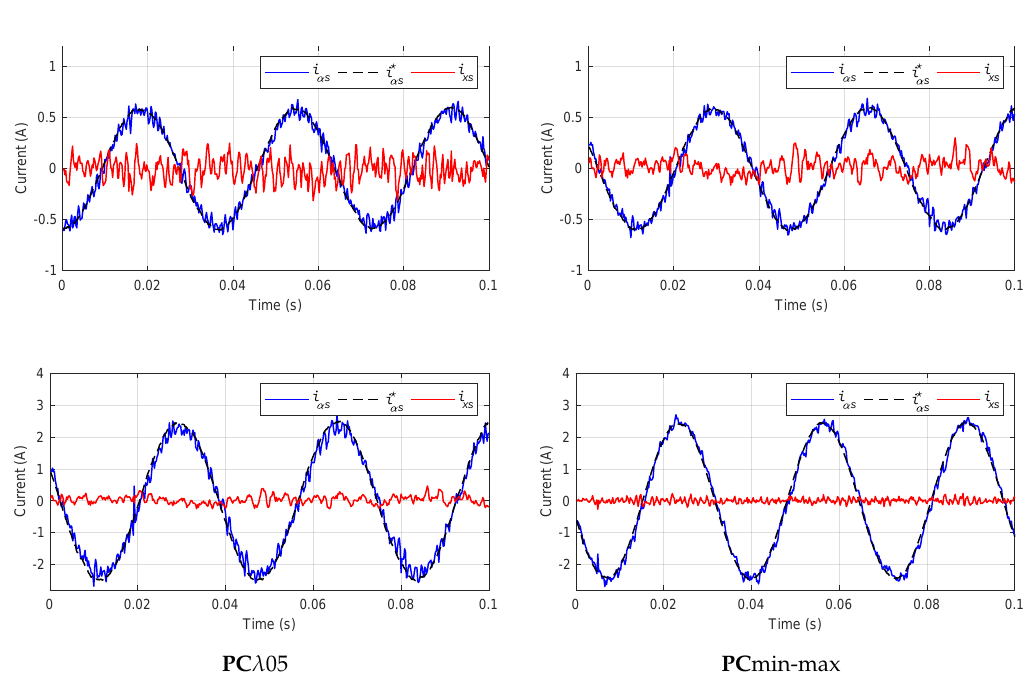
Figure 2. Simulation comparison of the proposed controller ( right ) against a traditional FCSMPC ( left ) at operating regimes S1 and S2 ( top and bottom